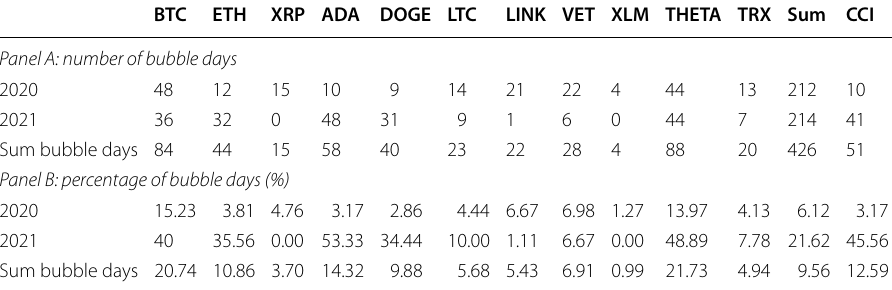
Table 3 Statistics of the bubble period